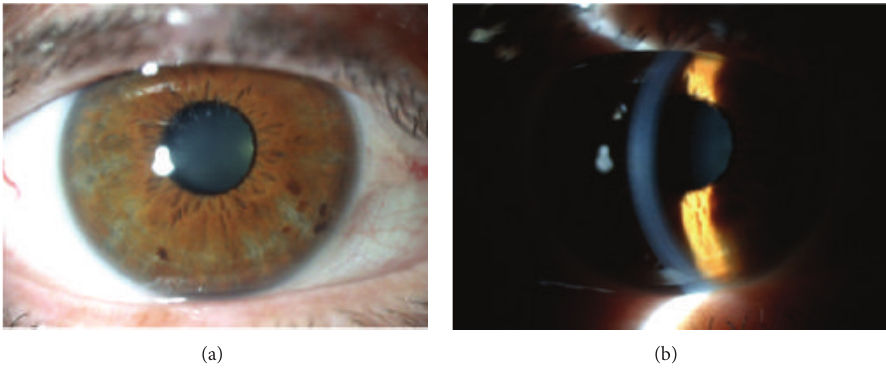
Figure 5: RE: complete resolution at